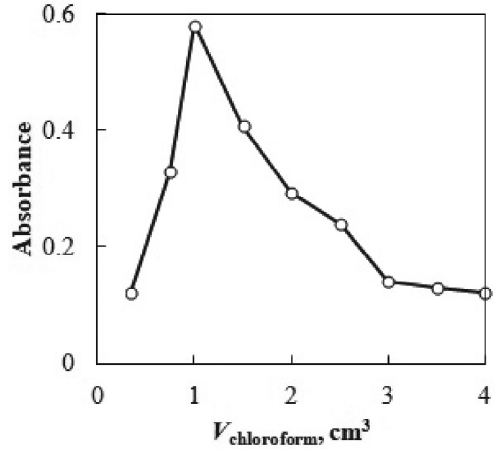
Fig. 3. Effect of volume of extracting solvent (chloroform) on ex- traction: 3.33 × 10 –5 mol/dm 3 of DHDPhB, 6.67 × 10 –7 mol/dm 3 of Cu(II), λ = 570